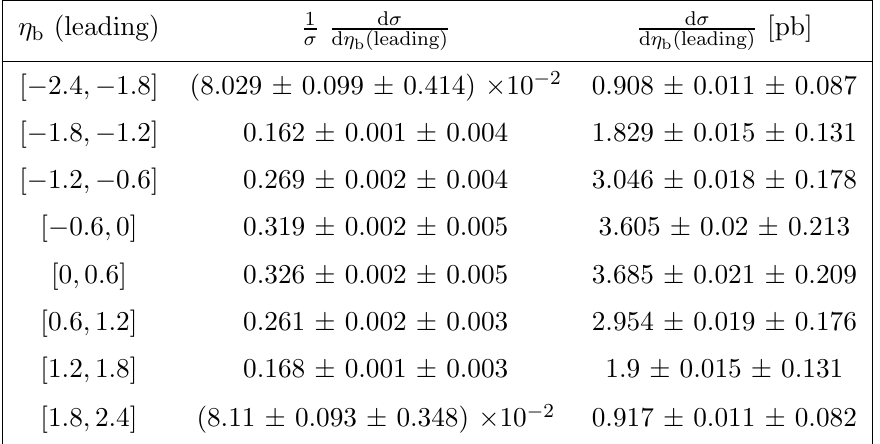
Table 43 . The measured di(cid:11)erential cross section and bin boundaries for each bin of the normalized and absolute measurements of the tt di(cid:11)erential cross section at particle level in the (cid:12)ducial phase space as a function of (cid:17) b (leading) are tabulated.